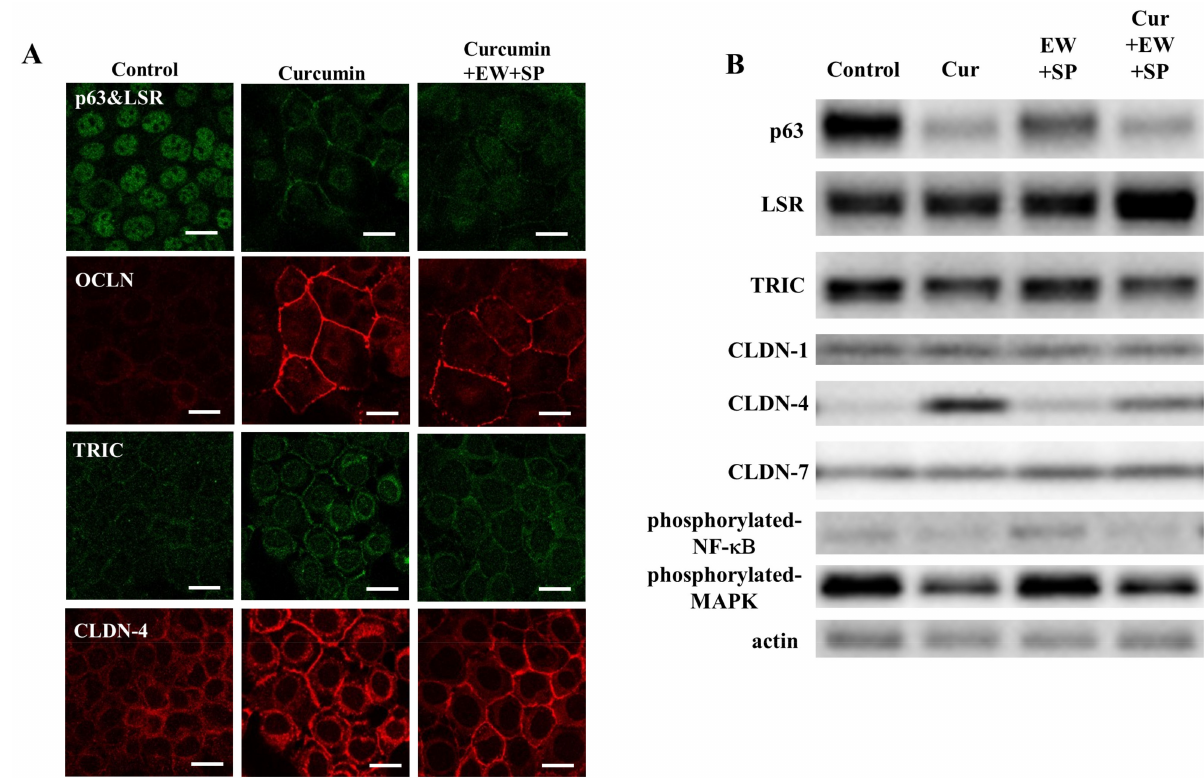
Figure 4. ( A ) Images of immunocytochemical staining for p63, LSR, OCLN, TRIC, and CLDN-4 in A253 cells treatment with NF- κ B inhibitor curcumin at 10 µ M under pretreatment, with or without EW-7197 (EW) and SP600125 (SP) at 10 µ M. Scale bar: 20 µ M. ( B ) Western blotting for p63, angulin-1/LSR, TRIC, CLDN-1, CLDN-4, CLDN-7, pNF- κ B, pMAPK, and actin in A253 cells treated with curcumin (Cur) at 10 µ M under pretreatment, with or without EW-7197 (EW) and SP600125 (SP) at 10 µ